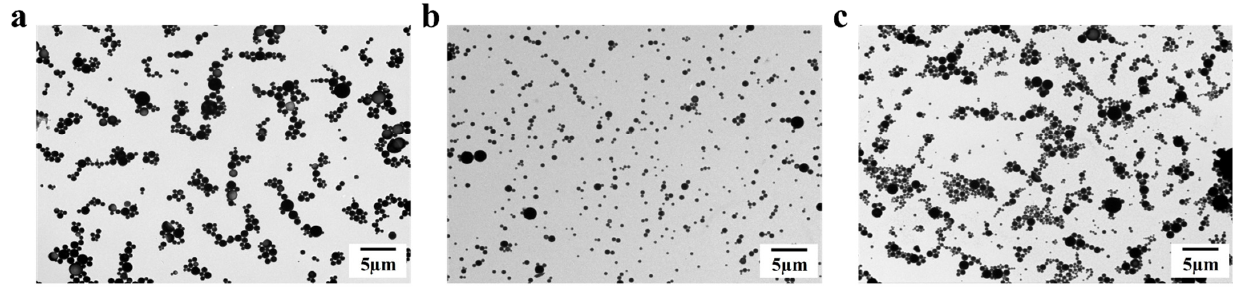
Figure 4. ( a ) Drug loading contents and ( b ) encapsulation efficiencies for chlorantraniliprole (Chl) and lambda cyhalothrin (LC) at different ultrasonic emulsification powers.